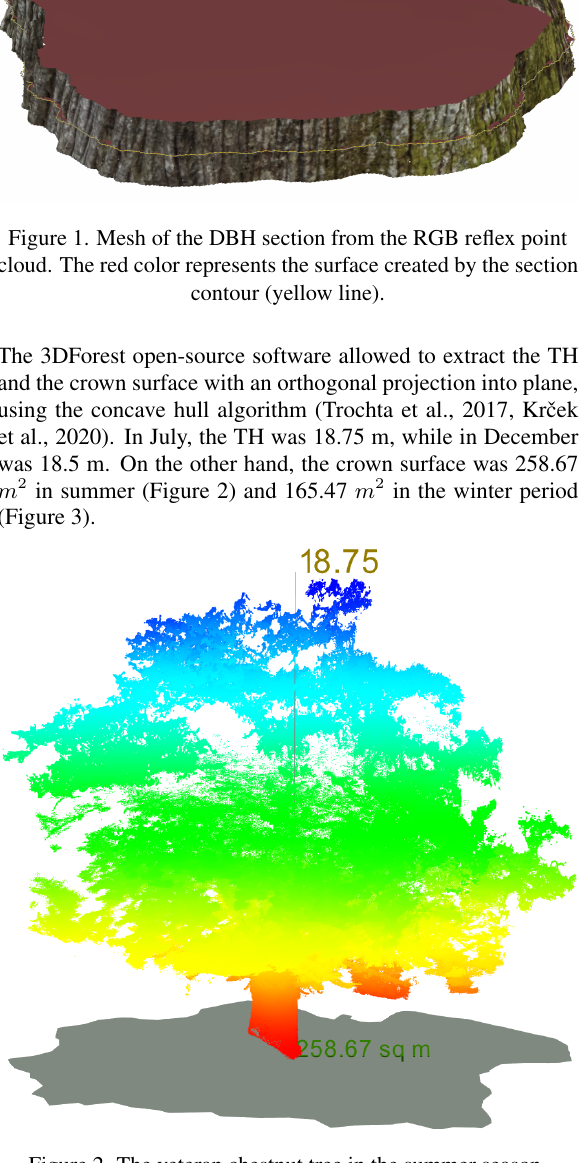
Figure 2. The veteran chestnut tree in the summer season. 3DForest outputs showing the TH (m) and the crown basal area (sq m). The color scale is in accordance with the z-axis